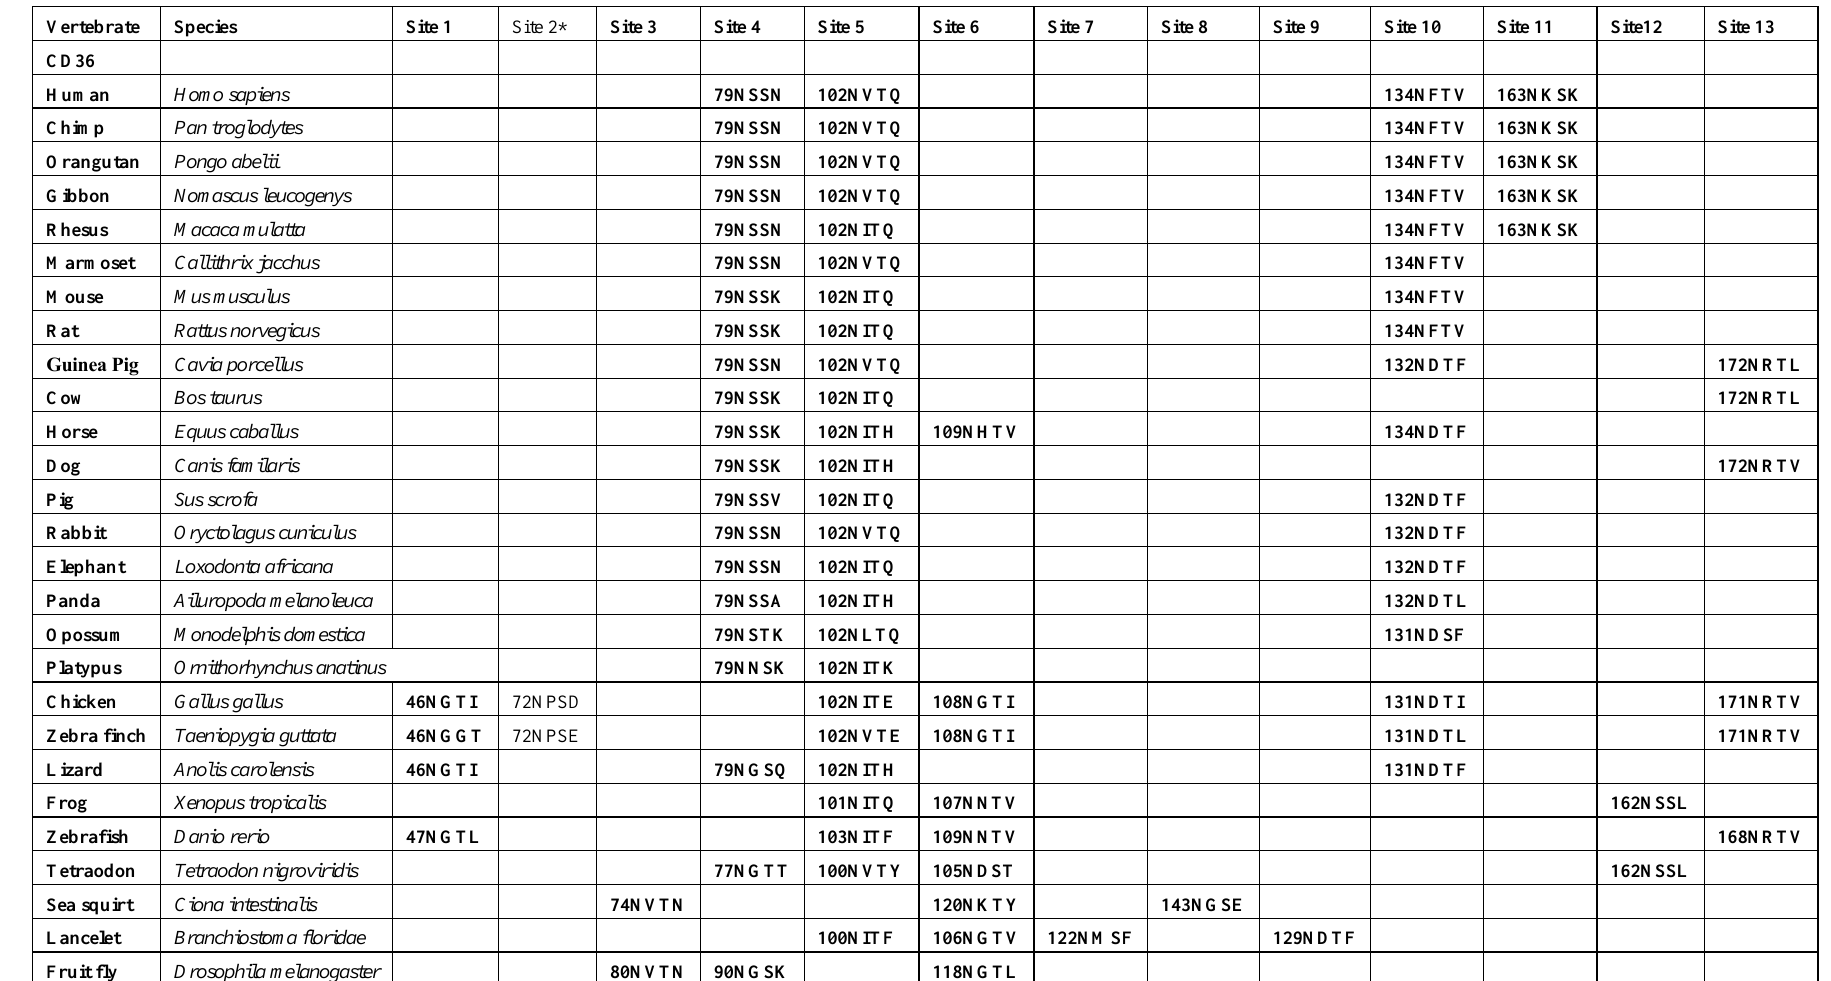
Table 2. Predicted N -glycosylation sites for CD36 sequences. Numbers refer to amino acids in the acid sequences, including N -asparagine; K-lysine; I-isoleucine; H-histidine; S-serine; T-threonine; Q-glutamine; D-aspartate; Y-tyrosine; and V-valine. Note that there are 25 potential sites identified for vertebrate CD36 and other CD36-like sequences, including 10 sites for human CD36 (see [49]). N -glycosylation sites were identified using the NetNGlyc 1.0 web server (http://www.cbs.dtu.dk/services/NetNGlyc/). Higher probability N -glycosylation sites are in bold